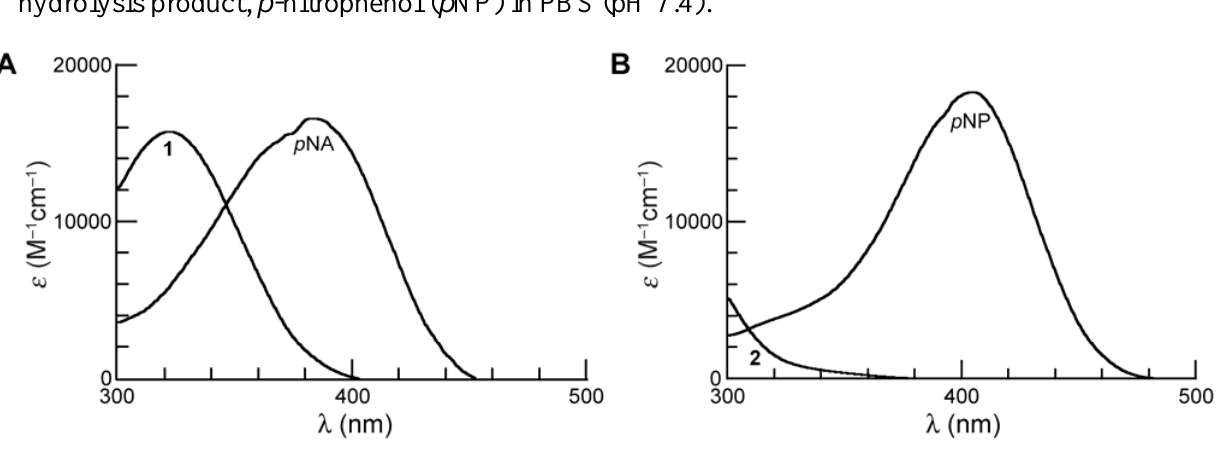
Figure 2. (A) Absorbance spectra of prochromophore 1 and its hydrolysis product, p -nitroaniline ( p NA), in PBS (pH 7.4). (B) Absorbance spectra of p -nitrophenyl acetate ( p NPA; 2 ) and its hydrolysis product, p -nitrophenol ( p NP) in PBS (pH 7.4).